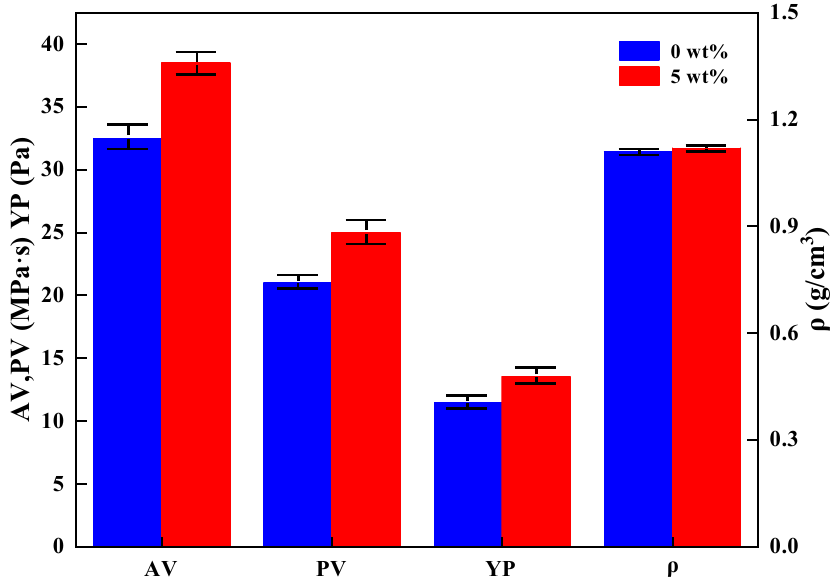
Figure 12. Rheological parameters and density of drilling fluid with or without microcapsules.